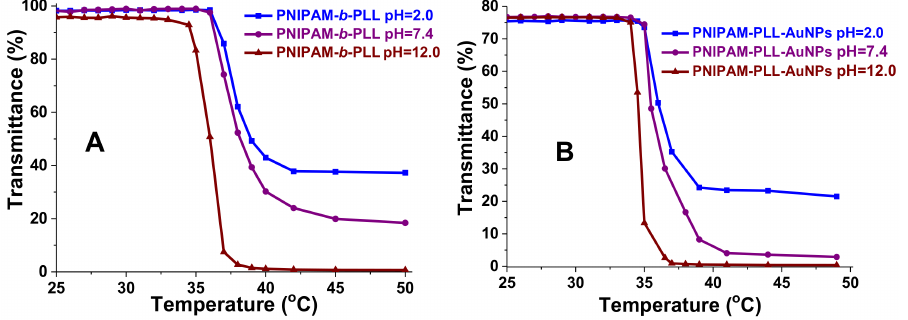
Figure 7. Temperature dependences of optical transmittance at 700 nm obtained for aqueous dispersions of PNIPAM- b -PLL ( A ) and PNIPAM-PLL-AuNPs ( B ) under different pH conditions at room temperature (Concentration: 2.0